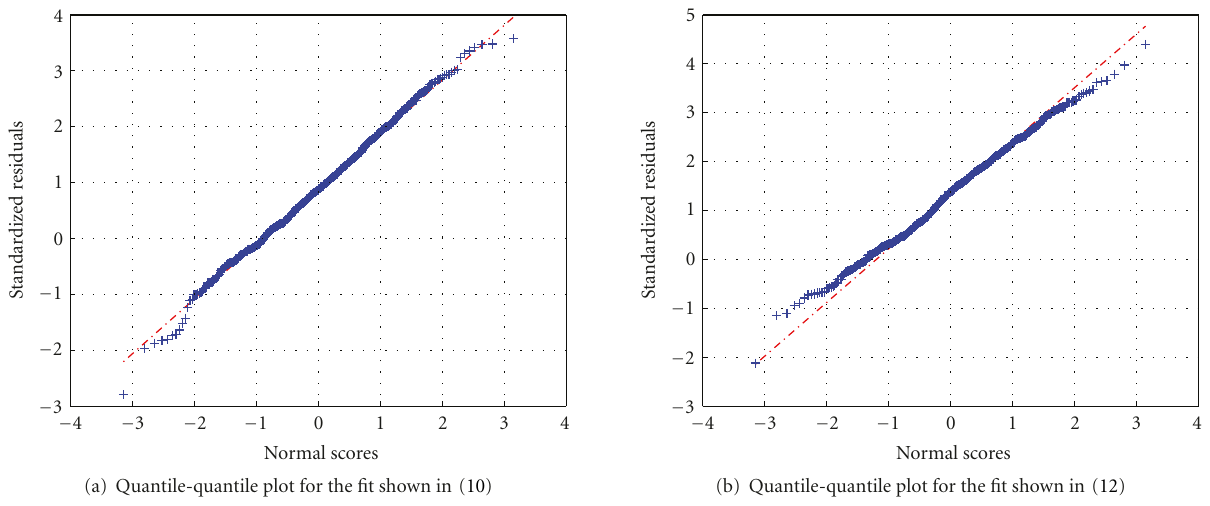
Figure 2: Quantile-quantile plots for the proposed linear mixed-e ff ects